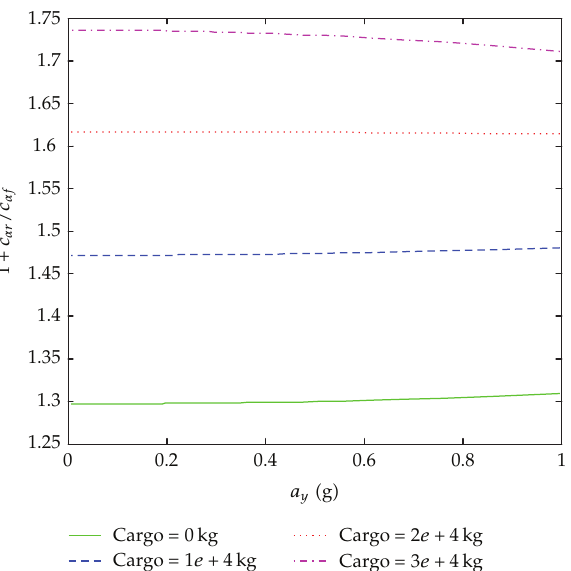
Figure 5: Ratio of rear tire’s to front tire’s cornering sti ff ness.